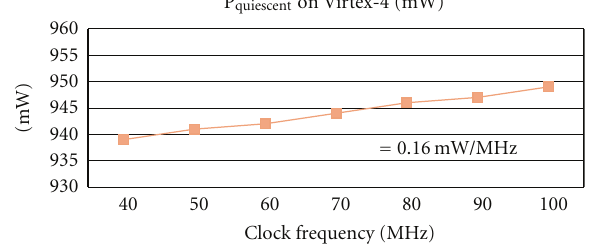
Figure 13: Impact of the clock frequency to the static power consumption of a uniprocessor design on a V4FX100.